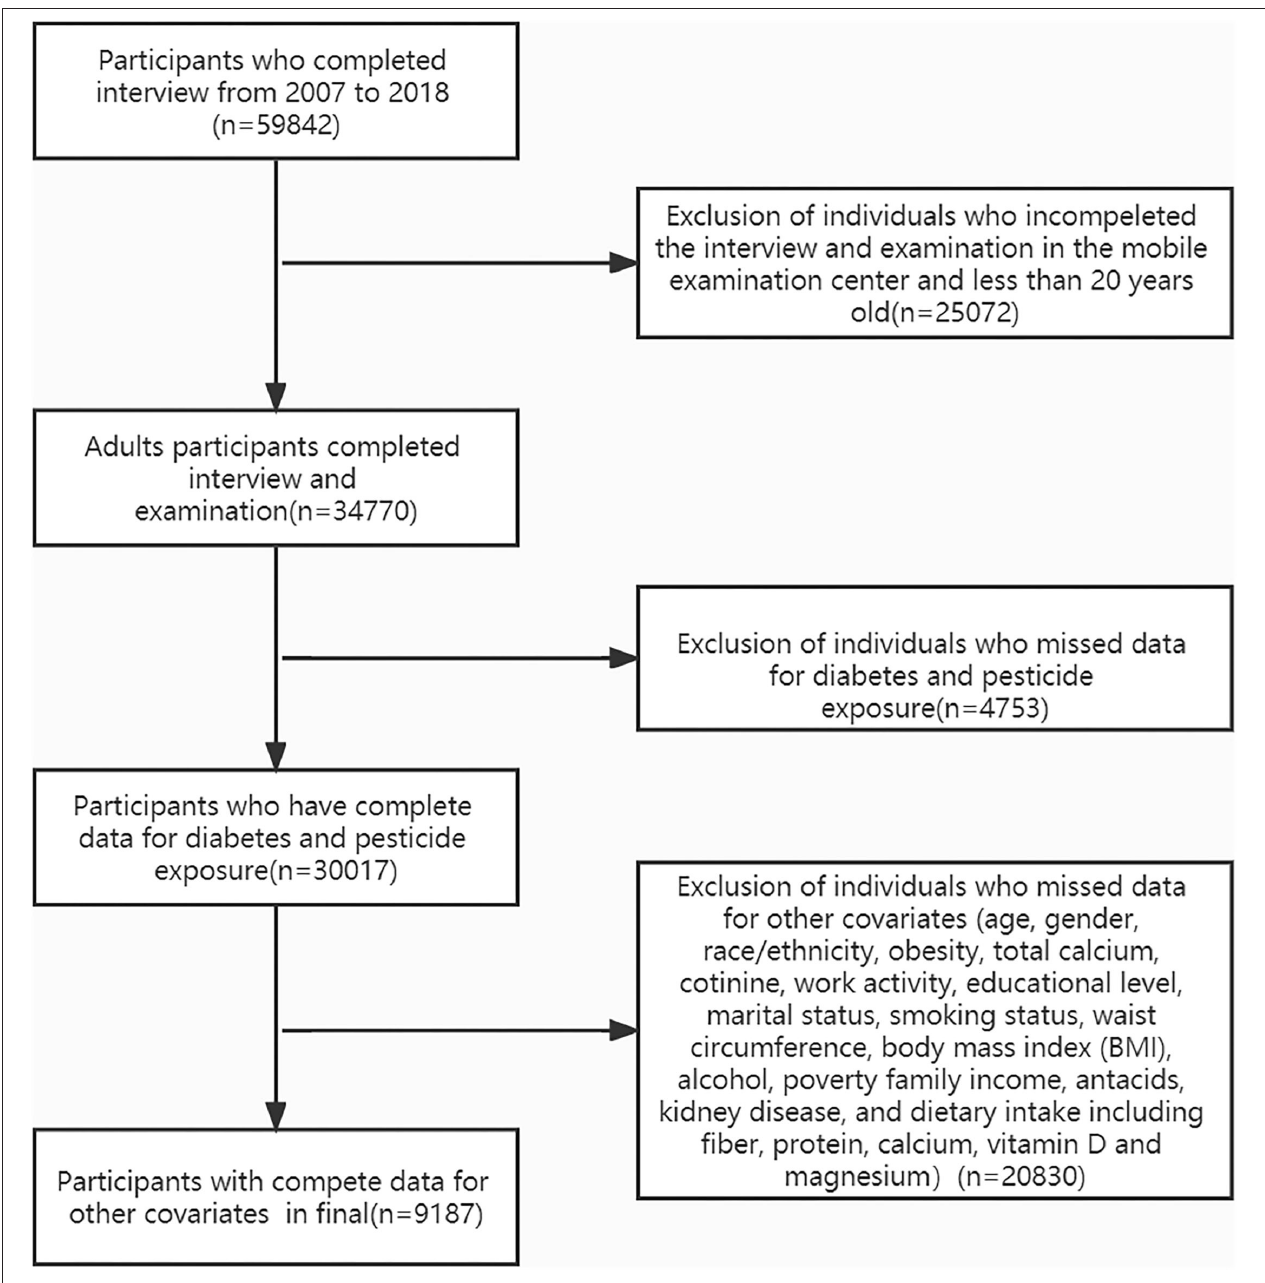
FIGURE 1 | The flow chart of the